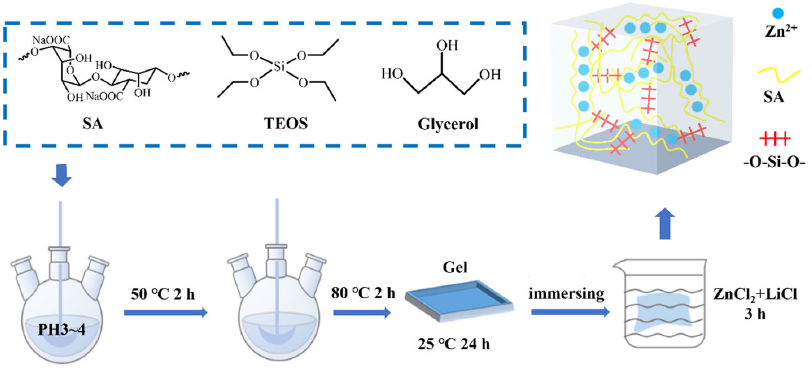
Figure 1. Schematic diagram of the preparation of SiO 2 ‐ SA GPE.